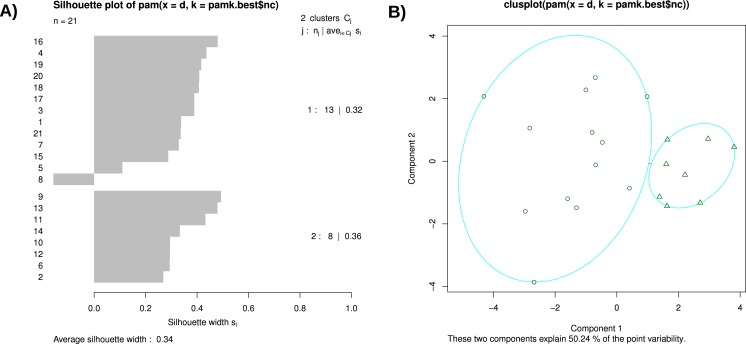
(A) Silhouette plot and (B) Silhouette plot based clusters.